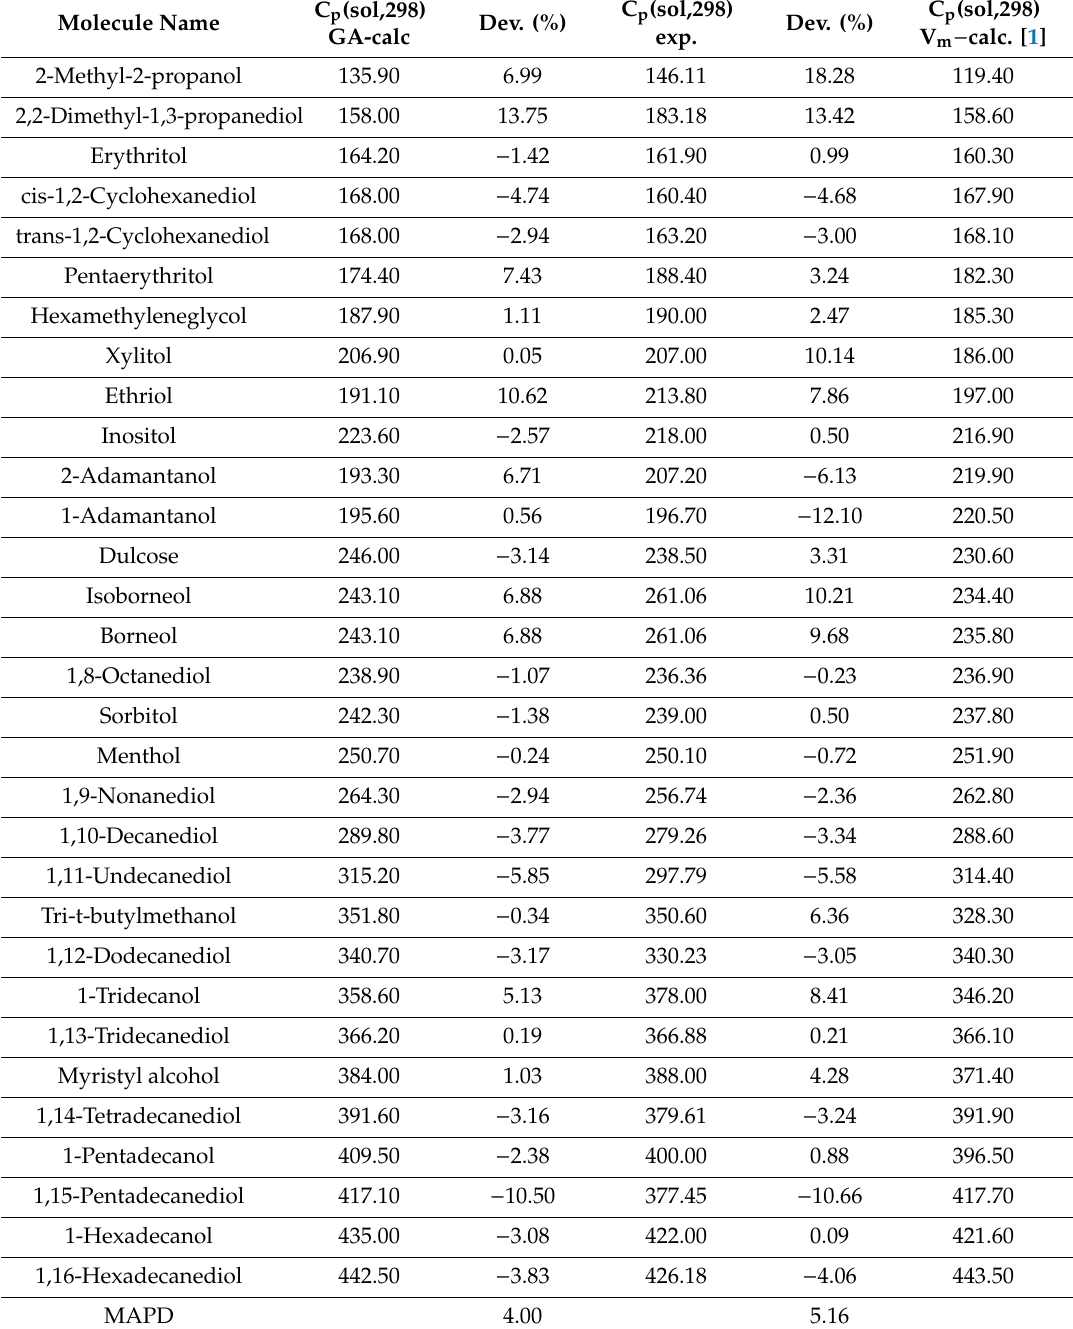
Table 8. Experimental C p (sol,298) data of 31 alkanols, compared with prediction values calculated by the present GA and the V m [1] method (in J / mol /